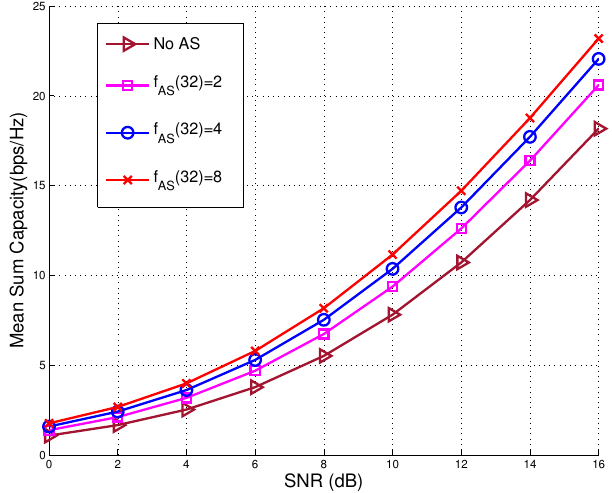
Figure 4. Achievable sum capacity performance comparison of proposed AS aided MU-MIMO system associated with K = 8 active users, N T = 32 transmit RF chains, and various AS factor, in comparison to that of conventional MU-MIMO without